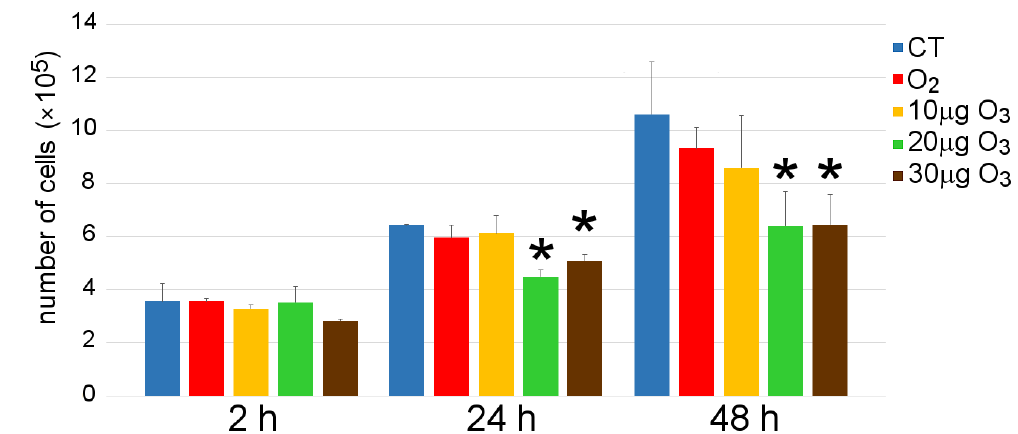
Figure 2. Diagrams show the mean value ± SD of the number of viable Jurkat cells after 2 h, 24 h, and 48 h from gas treatment. The asterisks (*) indicate significant difference with the respective control (CT).